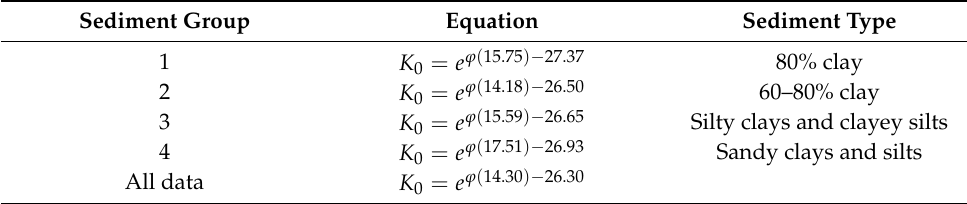
Table 3. Equations for permeability–porosity relationships